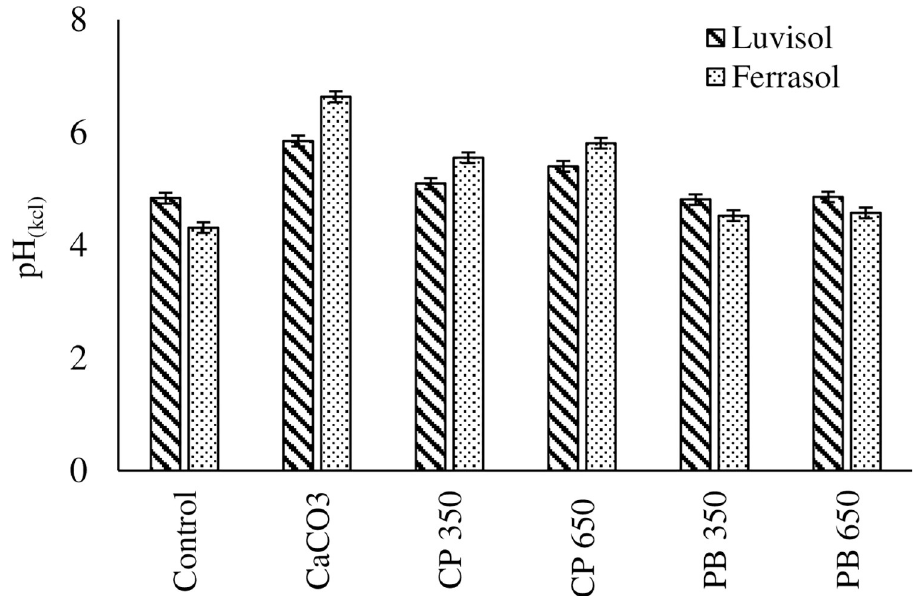
Fig 3. pH(KCl) values during a 10 day incubation of soils from luvisol and ferralsol amended with CaCO 3 = calcium carbonates and biochars from cull potato (CP) and pine bark (PB) produced at varying pyrolysis temperatures. Lime applied at recommended rate. CP 350 = Cull potato biochar at 350˚C; CP 650 = Cull potato biochar at 650˚C; PB 350 = Pine bark biochar at 350˚C; PB 650 = Pine bark biochar at 650˚C. The vertical error indicates LSD (P <